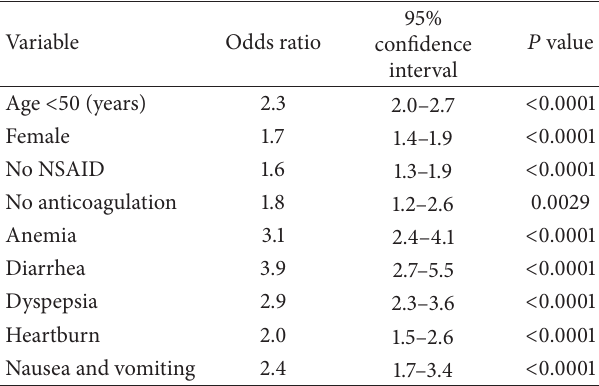
Table 2: Clinical predictors of macroscopically normal EGDs on multivariable logistic